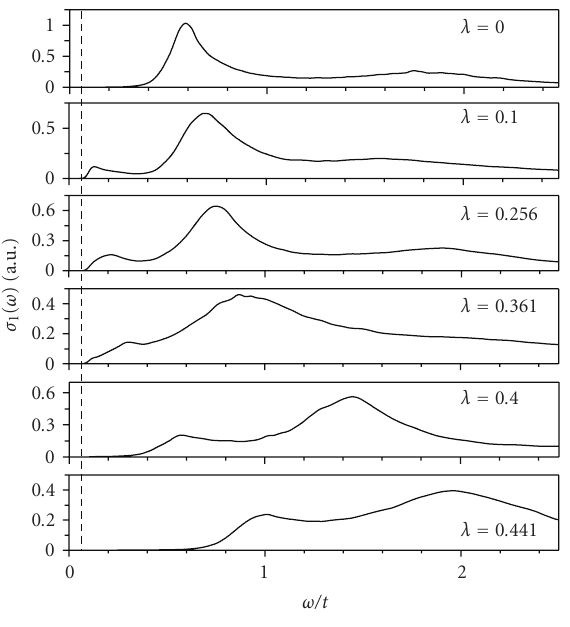
Figure 10: Optical conductivity of a one hole in the t-J-H model calculated by DMC method at J/t = 0 . 3 for di ff erent λ . Vertical line at ω/t = 0 . 1 shows phonon